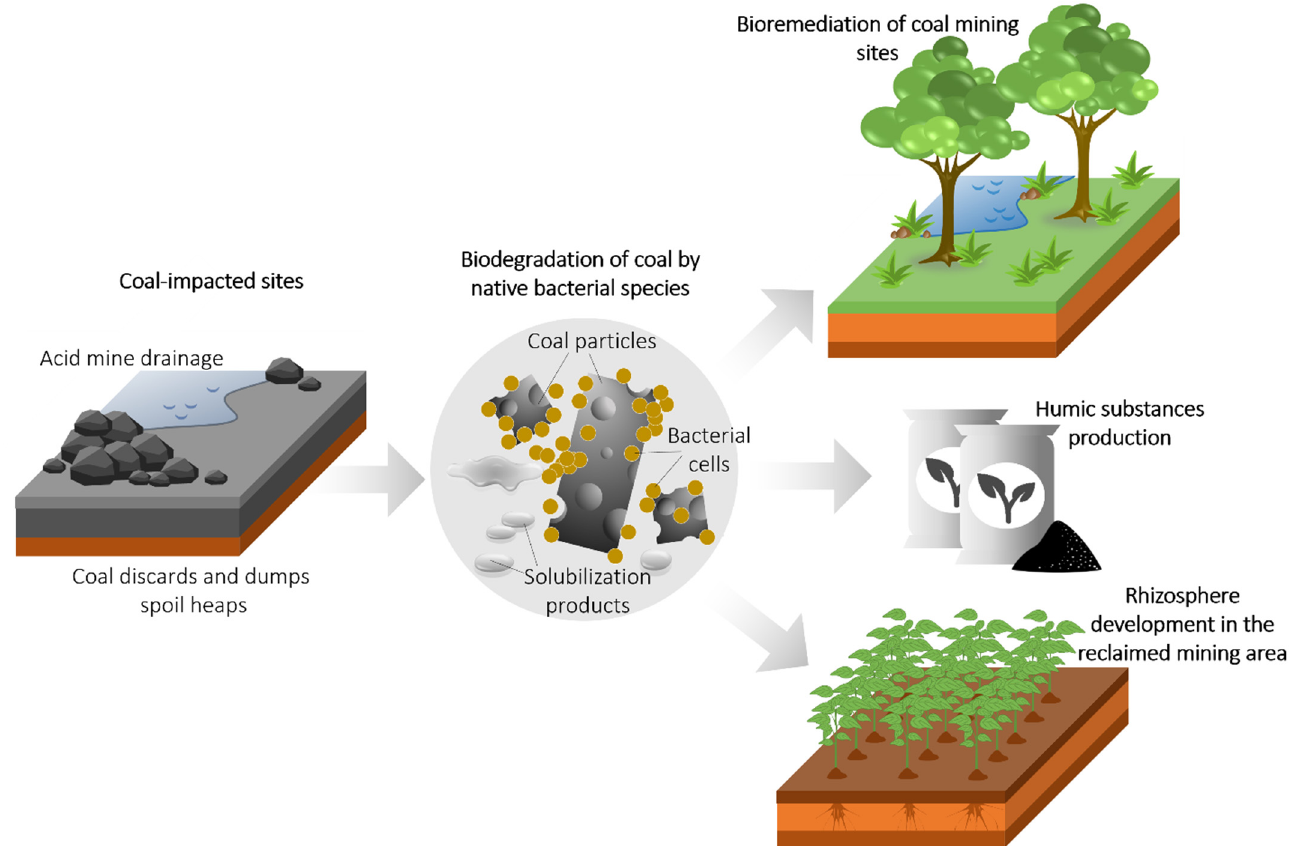
Figure 3. Exploiting indigenous “microbial cocktails” to degrade/convert coal from coal-impacted sites may have multi-faceted advantages in agricultural productivity and environmental sustainability, i.e., the bioremediation of post-coal mining sites, production of humified organic substances, and development of plant growth-stimulating bacteria. More detailed information is provided in the following sections. Table 2. Biodegradation of various coal sources through native consortia of bacteria: understanding the mechanisms, rates, and characterization of coal biodegradation is fundamental in the context of coal utilization/processing. This table considers only studies published since 2002 *.